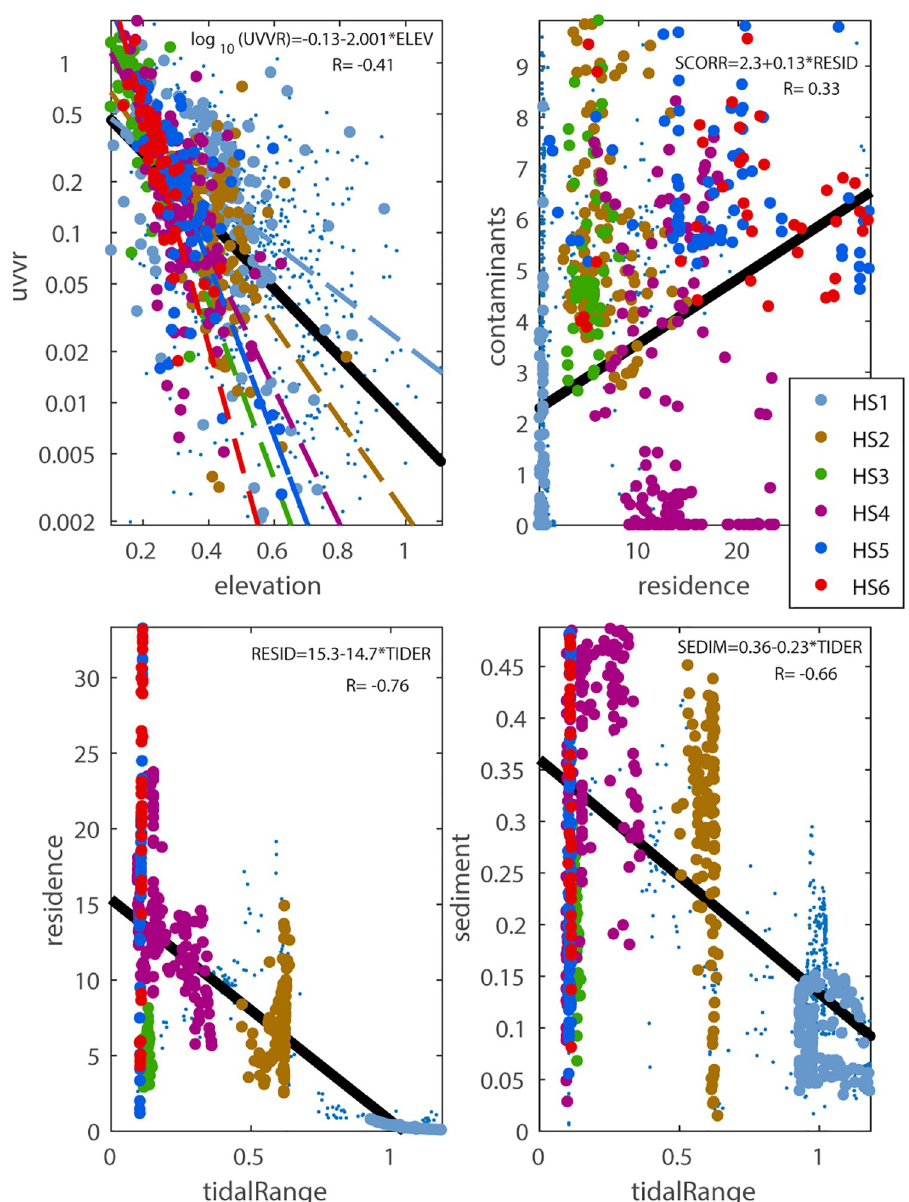
Fig 10. Relation between pairs of variables with significant (P < 0.001) correlations. a) UVVR vs elevation; b) Contaminants vs residence time; c) residence time vs tidal range; and d) sediment vs tidal range. The data points are color coded by each hotspot (see Fig 9 for hotspot location). The black line is the linear regression fit for each pair with equation and coefficient of determination indicated. For UVVR vs elevation individual regression lines for each hotspot are also displayed color